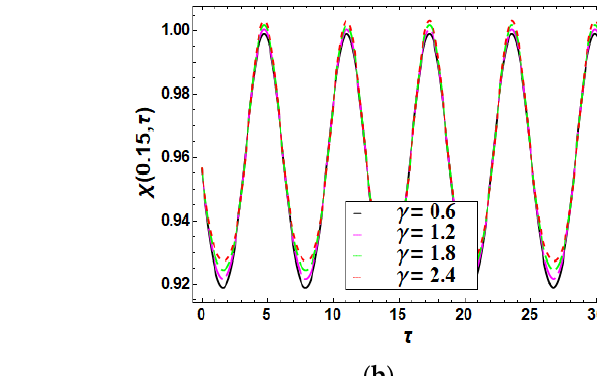
Ψ Ψ on φ . ( b ) E ff ects of 2 on φ . ( b ) E ff ects of 2